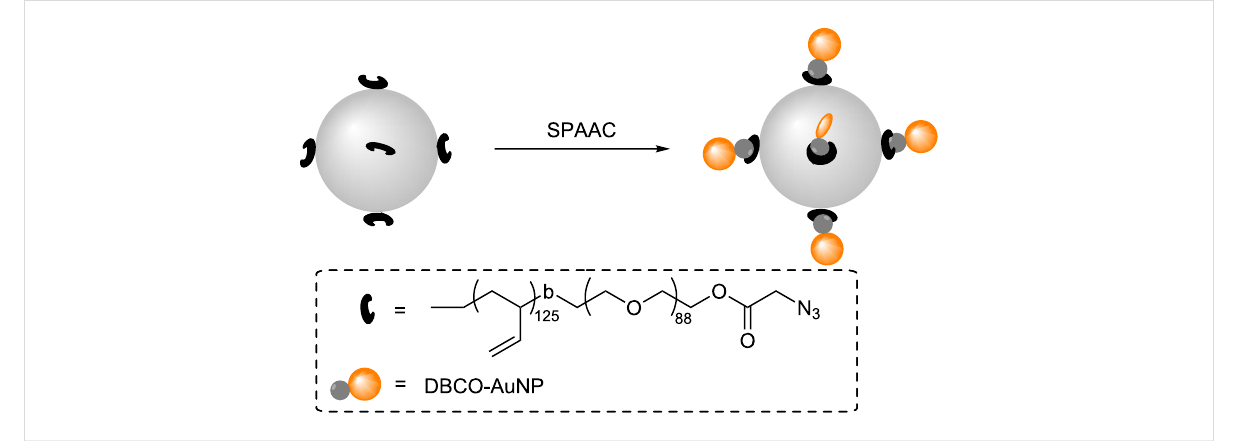
Scheme 6: A schematic representation of the SPAAC between azide-functionalized polymersomes and strained alkyne-functionalized AuNPs (DBCO-AuNPs) in water [57].